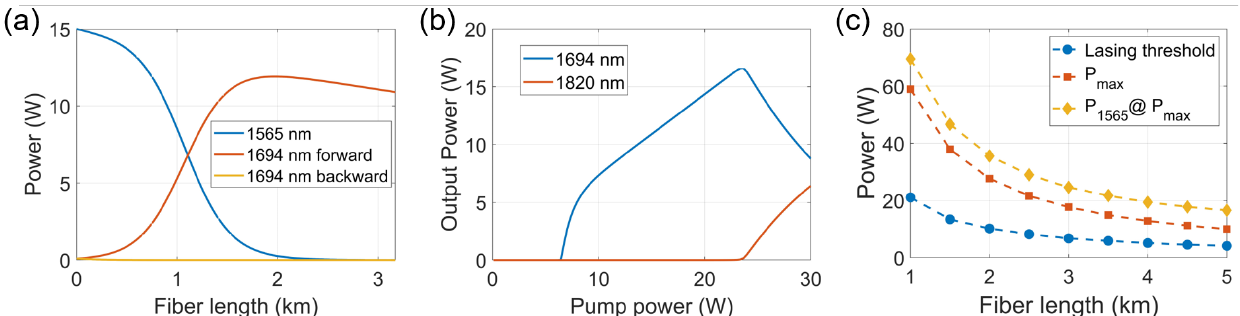
Figure 8. ( a ) Power distributions of the lasers pumped at 15 W; ( b ) output power versus the pump power when the length of SMF is 3.17 km; ( c ) lasing threshold, the maximum output power of the 1694 nm random lasing, and the corresponding pump power of 1565 nm as a function of the corresponding fiber length.